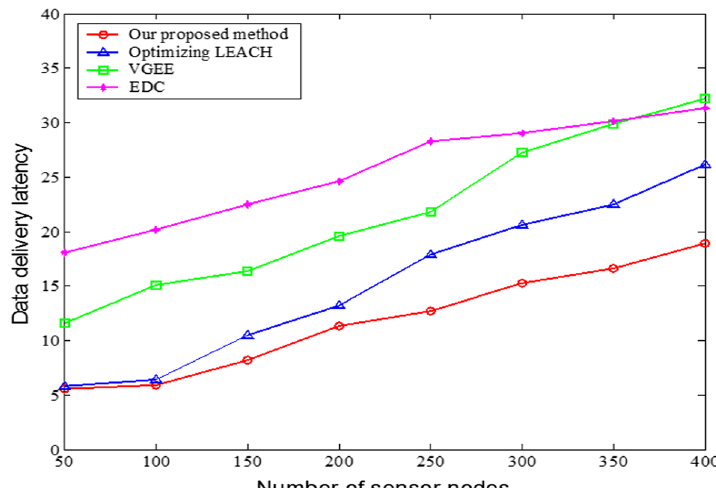
Fig. 5 Comparison of data delivery latency